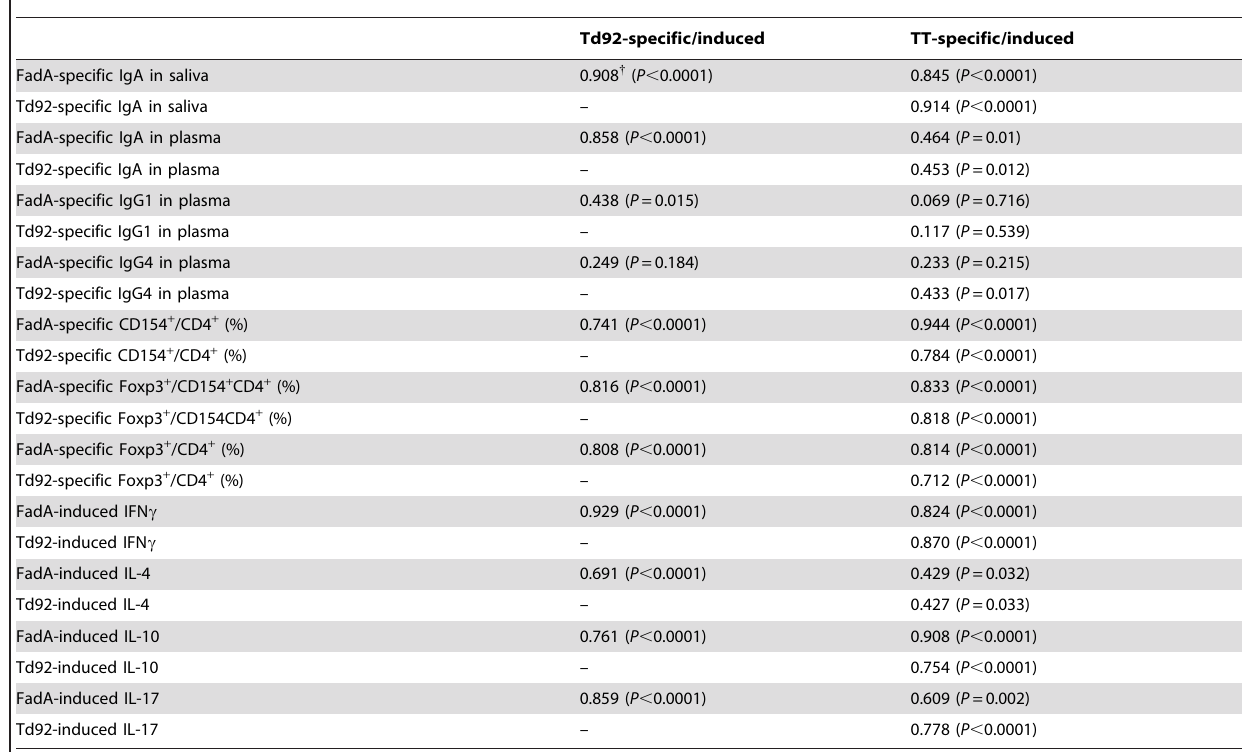
Table 2. Correlations of the examined immunologic parameters between the